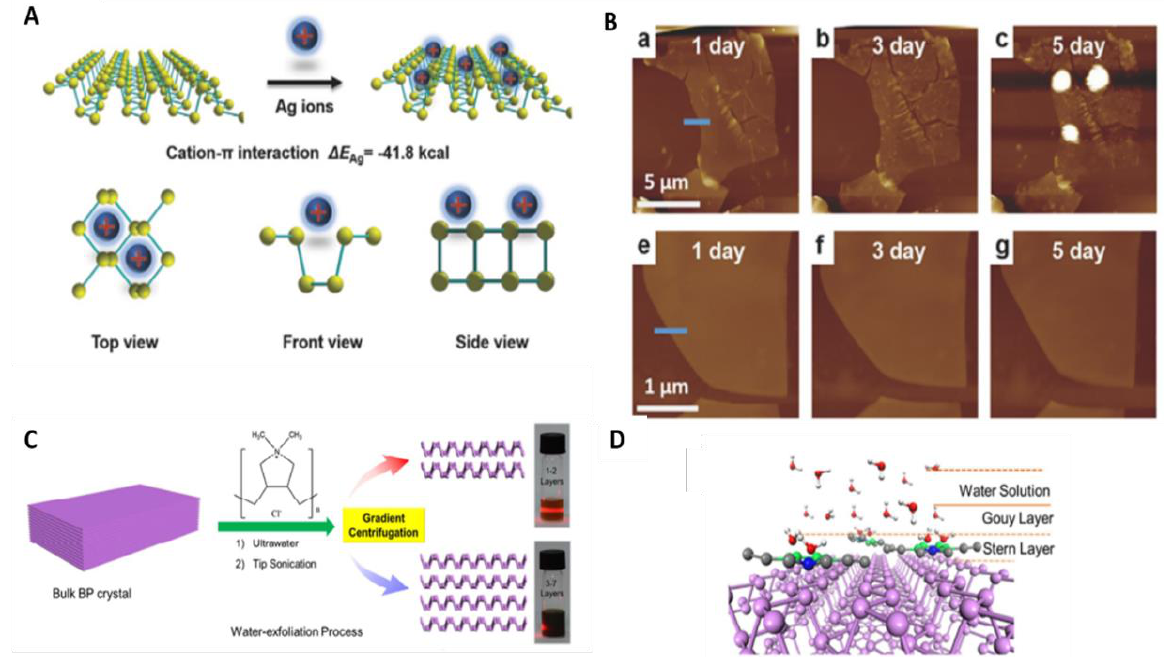
Figure 4. ( A ) Schematic for Ag + adsorbing on BP and their three different views; ( B ) AFM images of an unmodified BP sheet (top) and Ag + — modified BP sheet (bottom) exposed to air for one day, three days, and five days. Reproduced with permission [38]. Copyright 2017, Wiley. ( C ) Schematic of the fabrication process of exfoliated few-layer BP in water by PDDA, Tyndall effect of BP colloid solution via centrifugation at 15,000 rpm (top) and 11,000 rpm (down) with bulk BP crystal (10 mg). ( D ) Schematic of adsorption process for PDDA-BP nanosheets in water. Reproduced with permission [74]. Copyright 2018, ACS